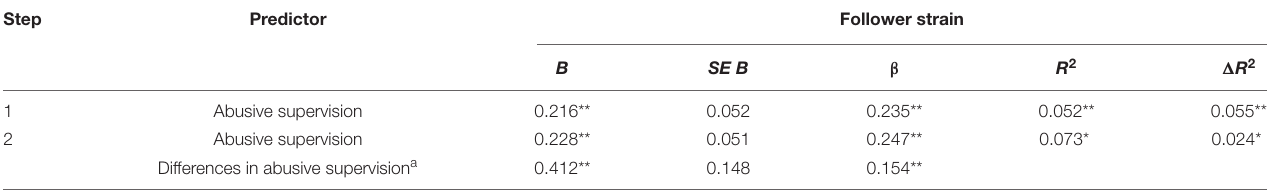
TABLE 3 | Hierarchical regression of follower strain on abusive